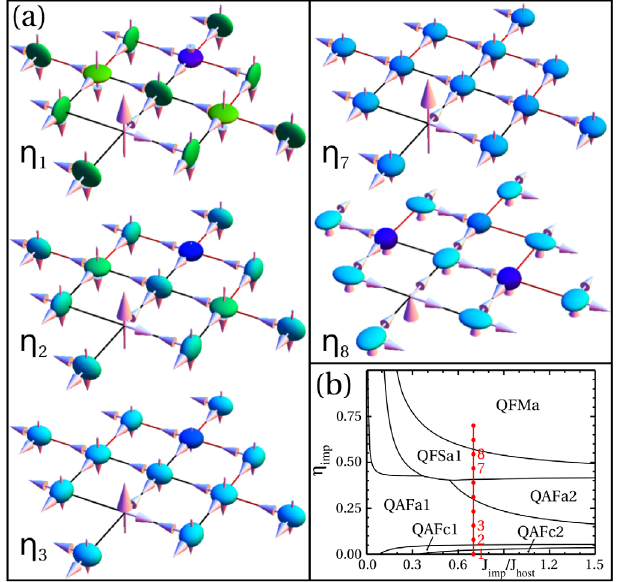
FIG. 16. (a) Evolution of the ground-state configurations as for increasing η and for a fixed value of spin-orbit coupling imp λ ¼ 0 . 5 J along a cut in the phase diagram shown in (b), i.e., host 0 . 7 J ≤ 0 . 7 . Arrows and ellipsoids for J and 0 ≤ η imp ¼ host imp indicate the spin-orbital state at a given site i . The color map indicates the strength of the average spin orbit h ~L · ~S ; i.e., red, i i i yellow, green, blue, and violet correspond to the growing amplitude of the above correlation